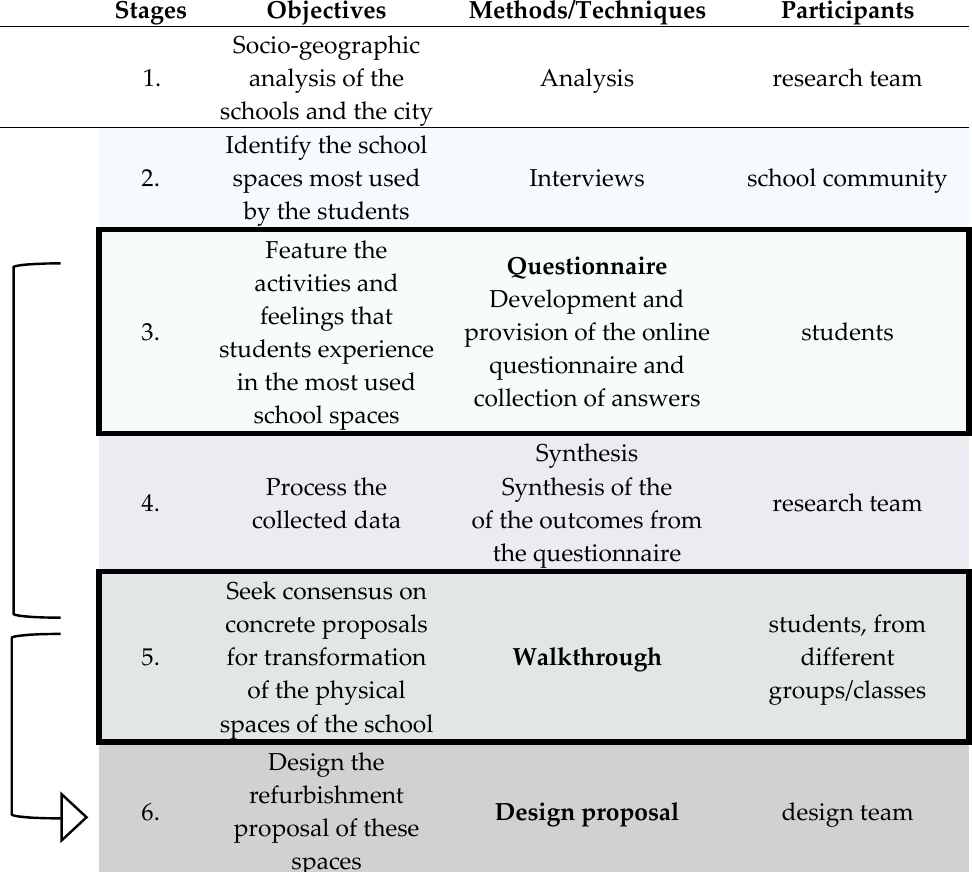
Table 2. List of questions for the questionnaire. Students Online